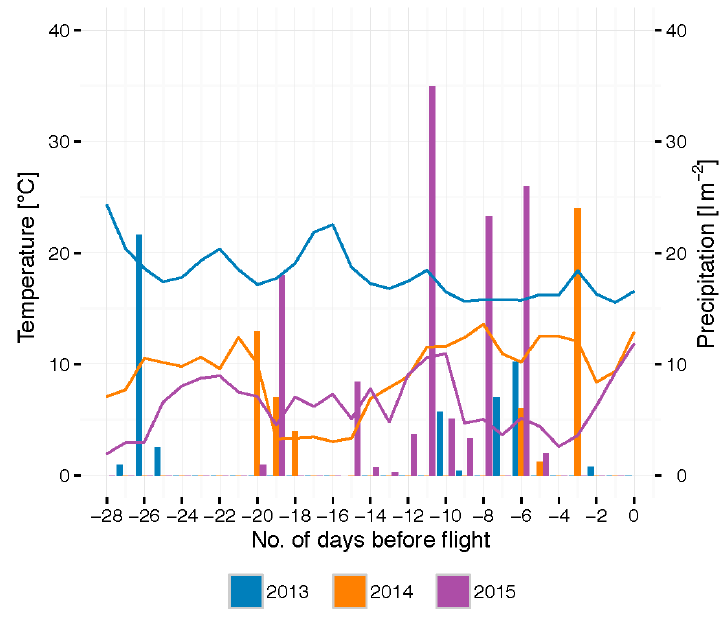
Figure 2. Precipitation (l · m − 2 ) and temperature data ( ◦ C) in the 28 days before the flight dates